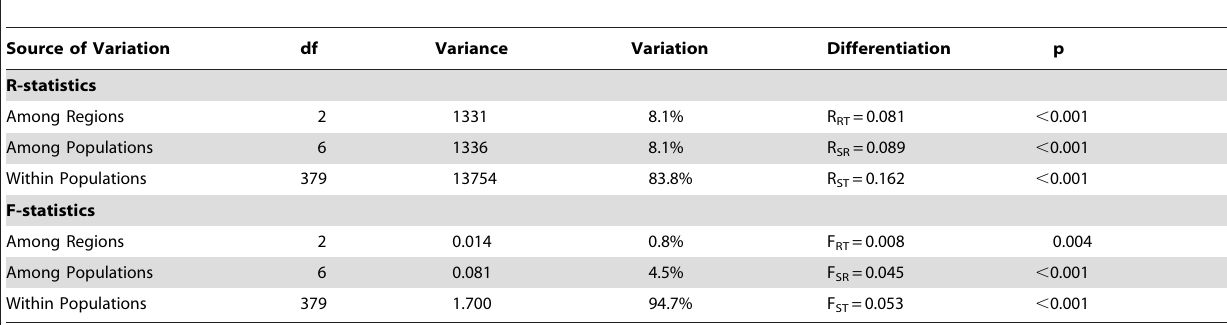
Table 3. Hierarchical AMOVA results showing levels of genetic structure among regions (R RT /F RT ), among populations within regions (R SR /F SR ) and among populations (R ST /F ST ).